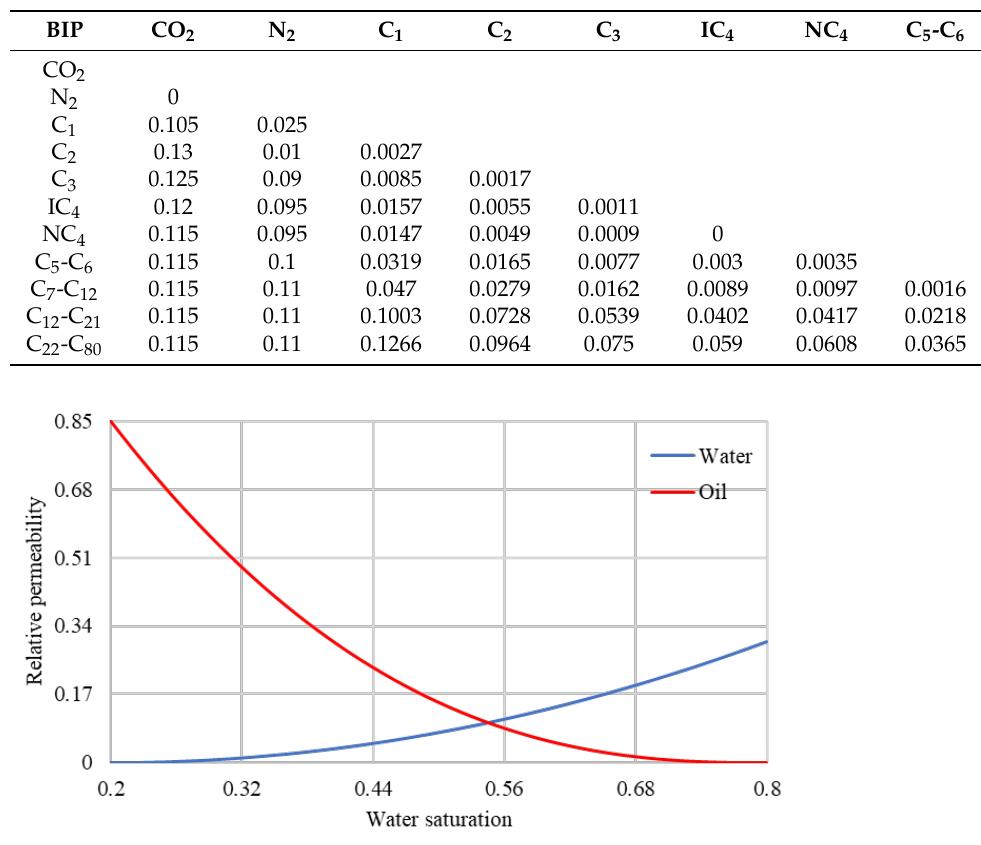
Figure 6. Stone-II relative permeability model.